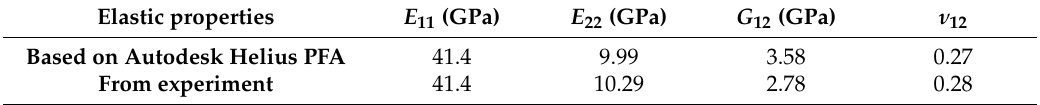
Table 3. Comparison of lamina material properties from experiment and model.